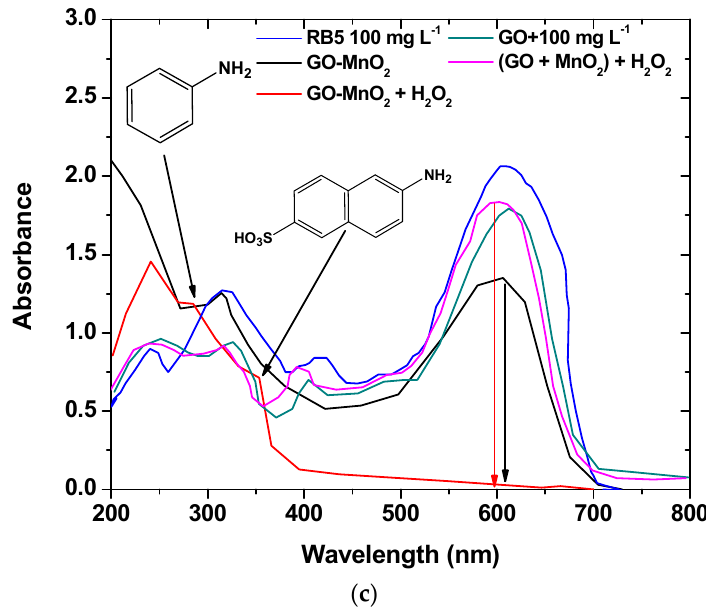
Figure 7. UV-Vis spectra illustrating: ( a ) the effect of different initial dye concentration; ( b ) the effect of H 2 O 2 on RB5 degradation; ( c ) the comparison between the performance of the nanocomposite catalyst and the mixture of the raw materials on RB5 degradation.